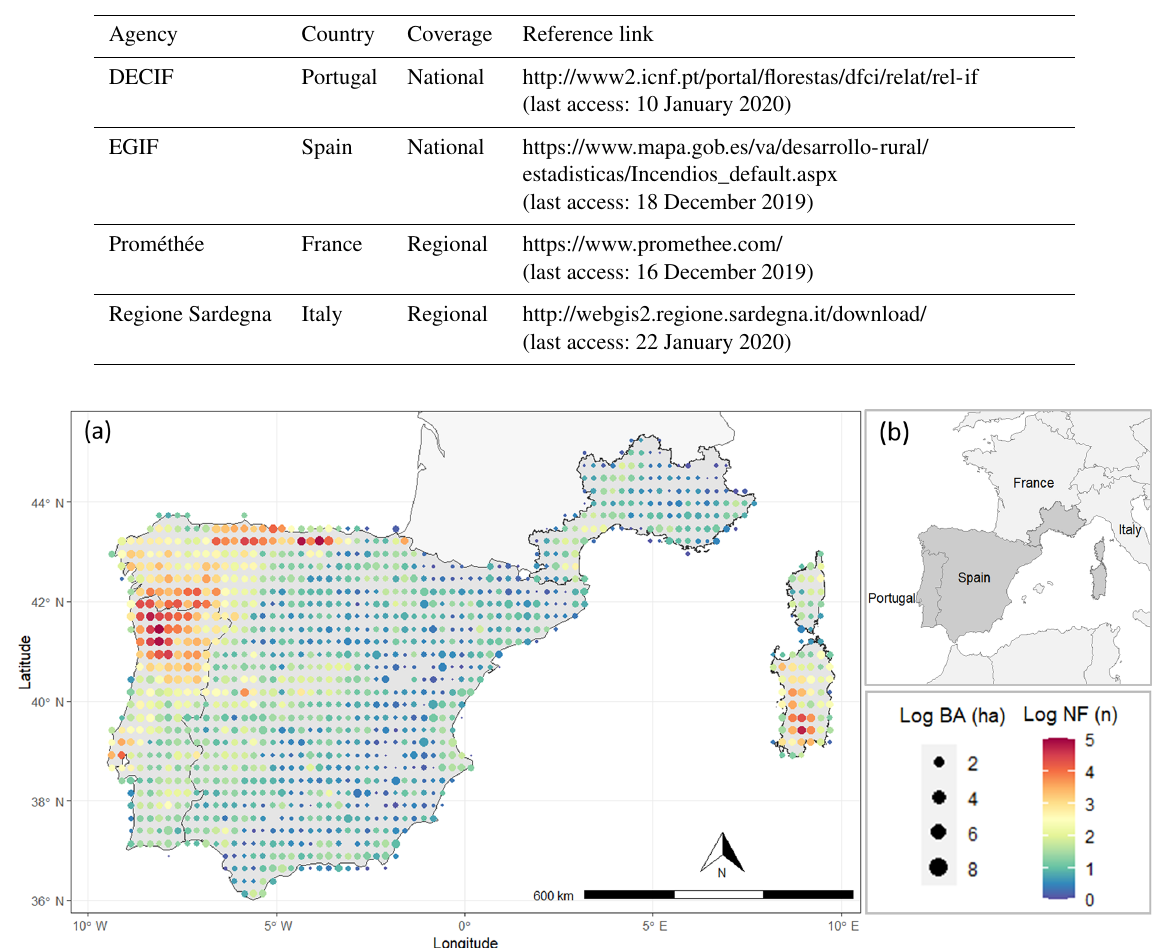
Figure 1. (a) Mean annual burned area (BA; depicted by circle size) and mean annual number of fires (NF; depicted by color) as observed in the GBD at 0.25 ◦ resolution over the study period (2005–2015). (b) Spatial extent of the study